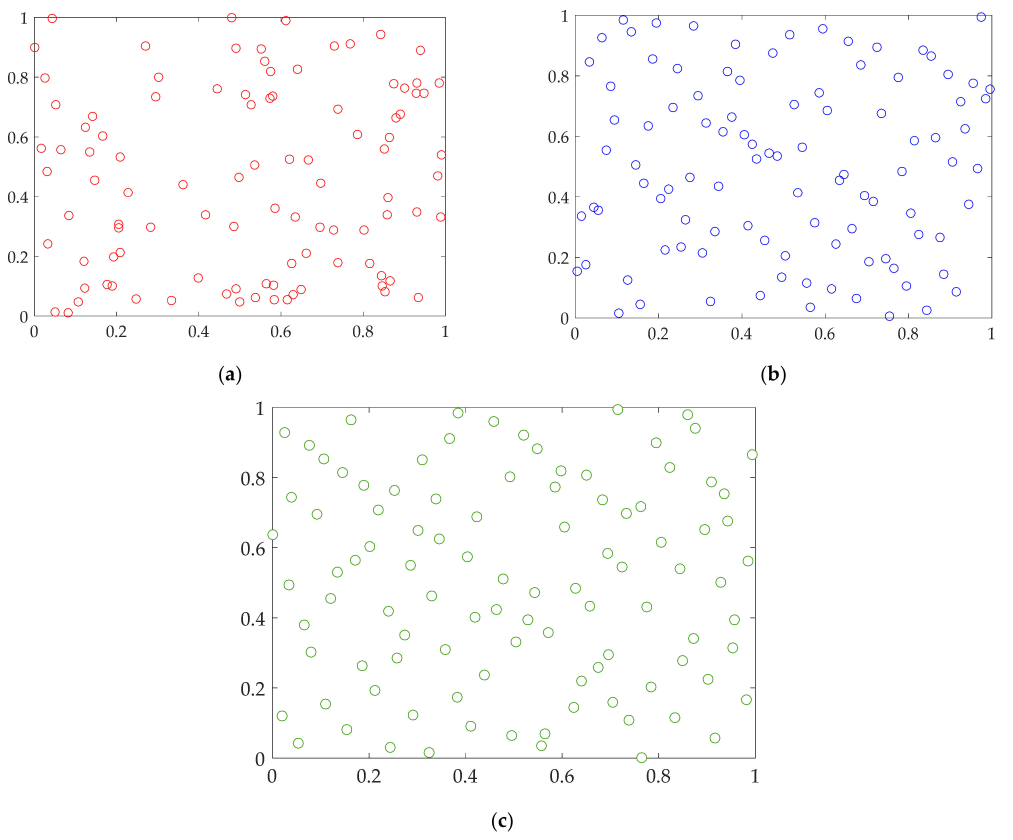
Figure 2. Comparison of 100 samples obtained by: ( a ) simple random sampling; ( b ) Latin Hypercube sampling; and ( c ) Halton quasi-random